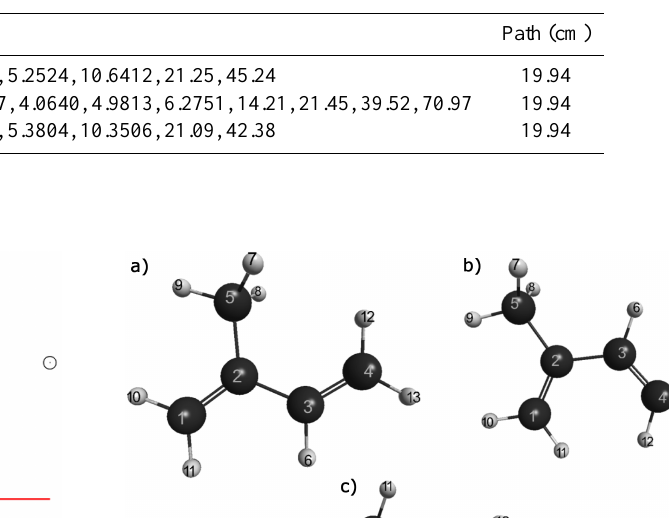
Table 2. Sample conditions for the isoprene measurements.